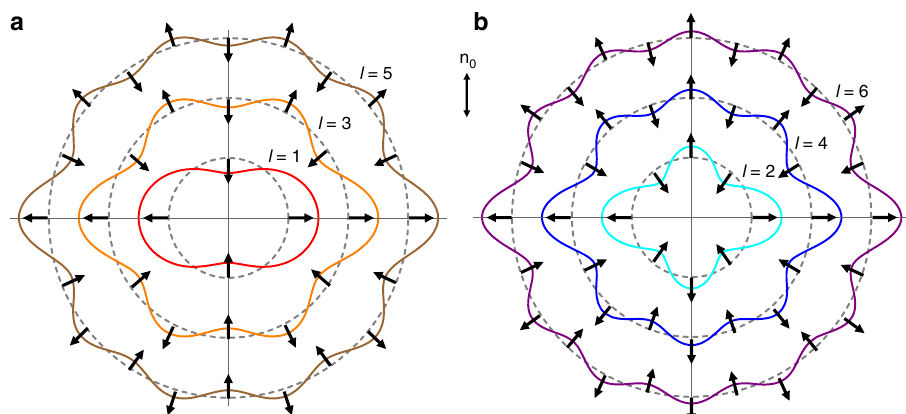
Fig. 7 Angular dependencies of elastic multipole pair interactions. Colored solid lines represent the interaction potential U el ∝ P l + m (cos( θ c )) between two multipoles of the same order, e.g. for l = m . a Interaction potentials between two dipoles, octupoles, and 32-poles ( l = 1, 3, and 5, respectively). b Interaction potentials between two quadrupoles, hexadecapoles, and 64-poles ( l = 2, 4, and 6, respectively). The double arrow indicates the far- fi eld director n 0 with respect to which θ c is measured. Dashed circles intersecting the potential plots represent equipotential lines of U ( θ c ) = 0 for each plot. Multipole pairs mutually repel in the regions where the lines extend beyond the dashed circle, e.g. U el > 0, and attract where the lines lie within the dashed circles, e.g., U el < 0. Such radial directions of interaction are marked by the black arrows. The plots are not presented to